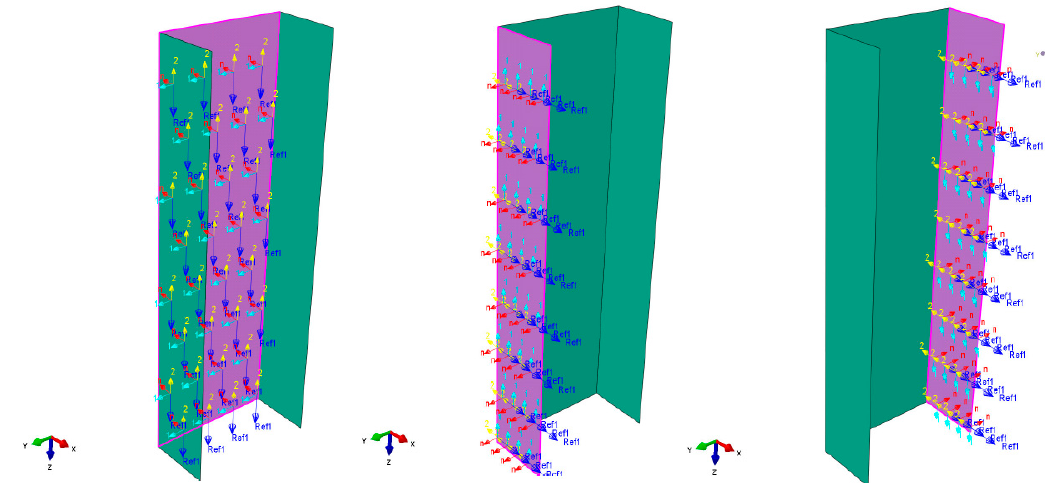
Figure 6. The fiber orientation definition of the web and flanges.